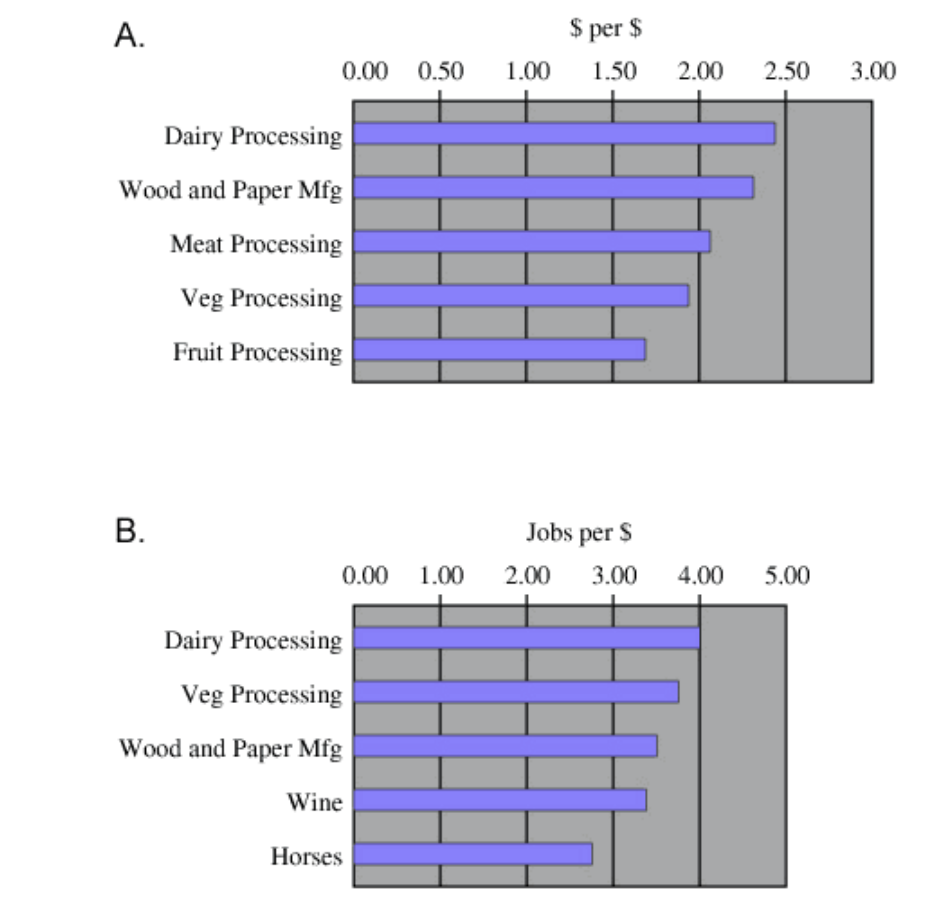
Fig. 5. a. Top five regional output multipliers. For example, each extra dollar of output from the dairy industry results in A$2.45 of extra output in the rest of the economy. b. Top five regional employment multipliers. For example, each extra job in dairy processing leads to four extra jobs in other sectors in the regional economy. (Source: Plant et al